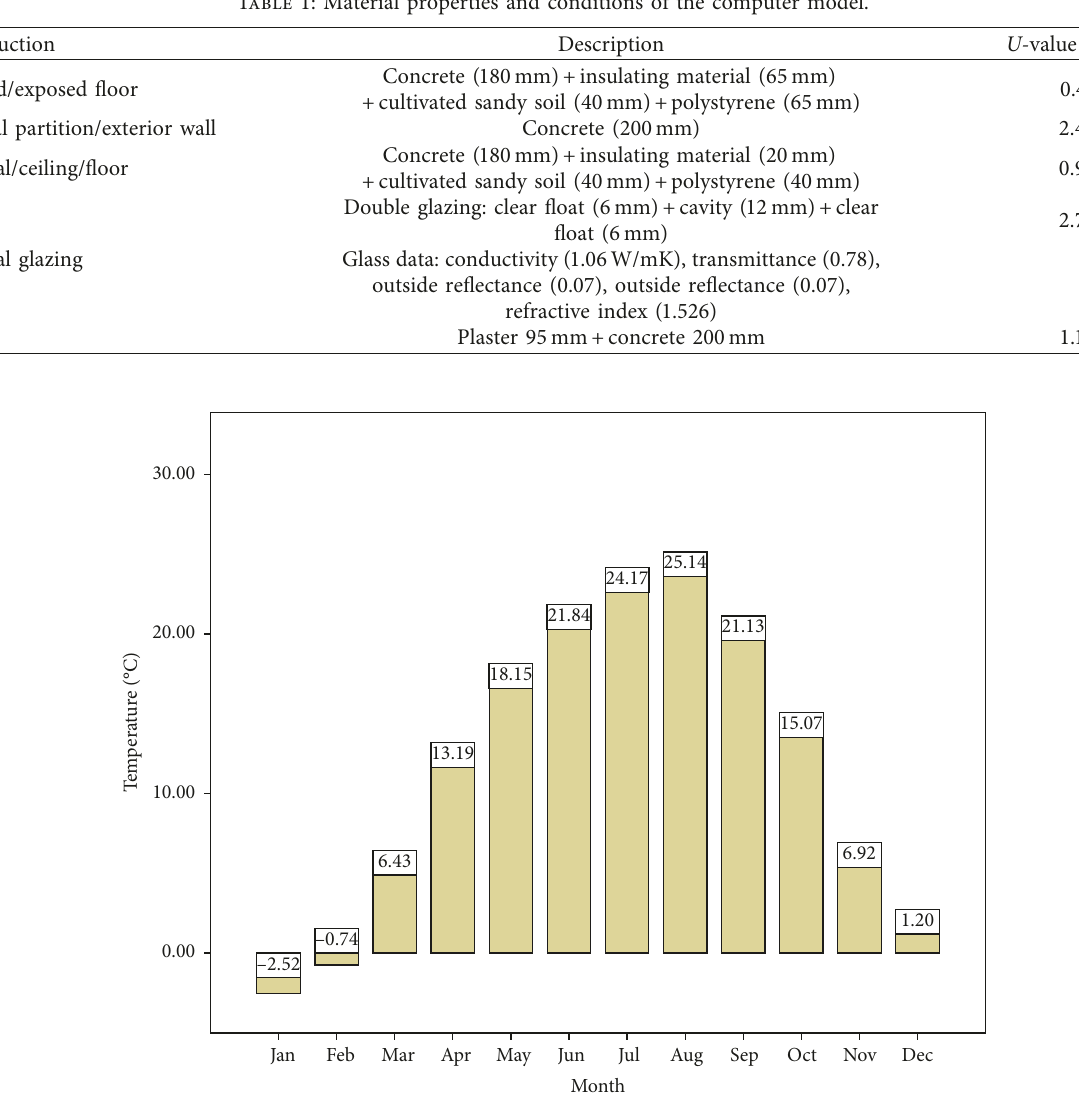
Figure 7: Monthly mean temperature during 30 years (1981 ∼